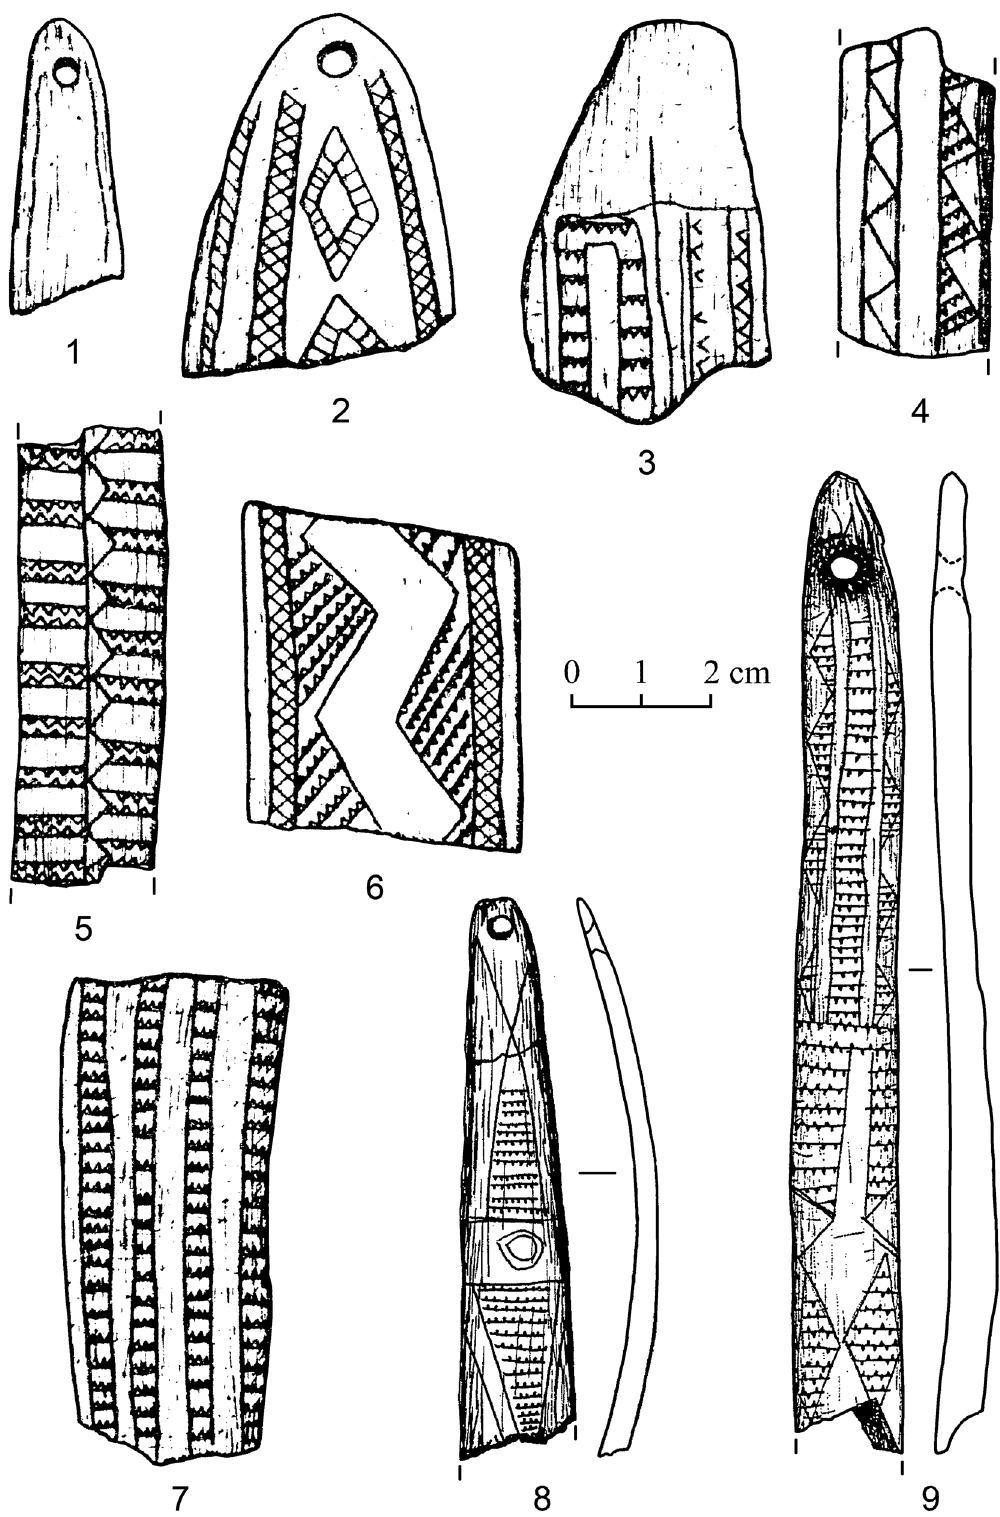
Figure 6: Bone plates from the Dnipro Rapids sites: 1 – 7 – Vasylivka II ( after Telegin, 1991, Figure 15 ) , 8, 9 – Kizlevyi Ostriv 5 ( after Tuboltsev, 2003, p. 44, Figure 6: 16, 18 )